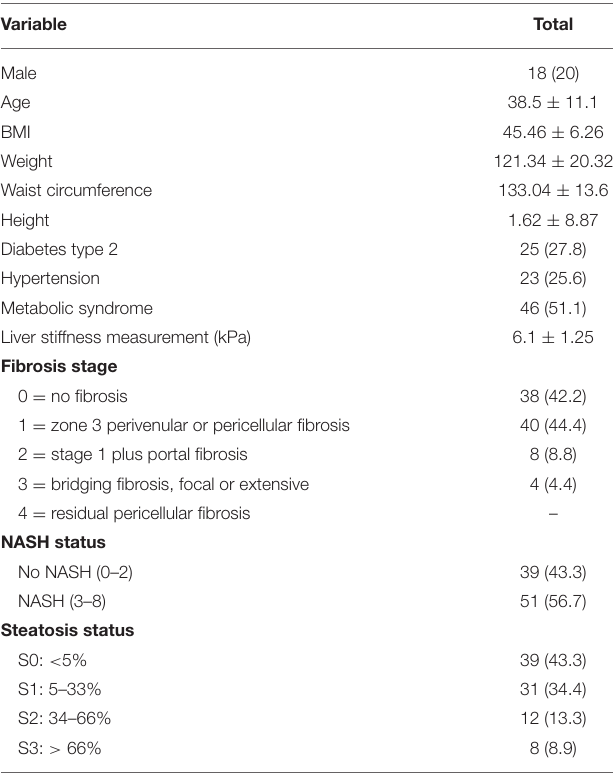
TABLE 1 | Patients’